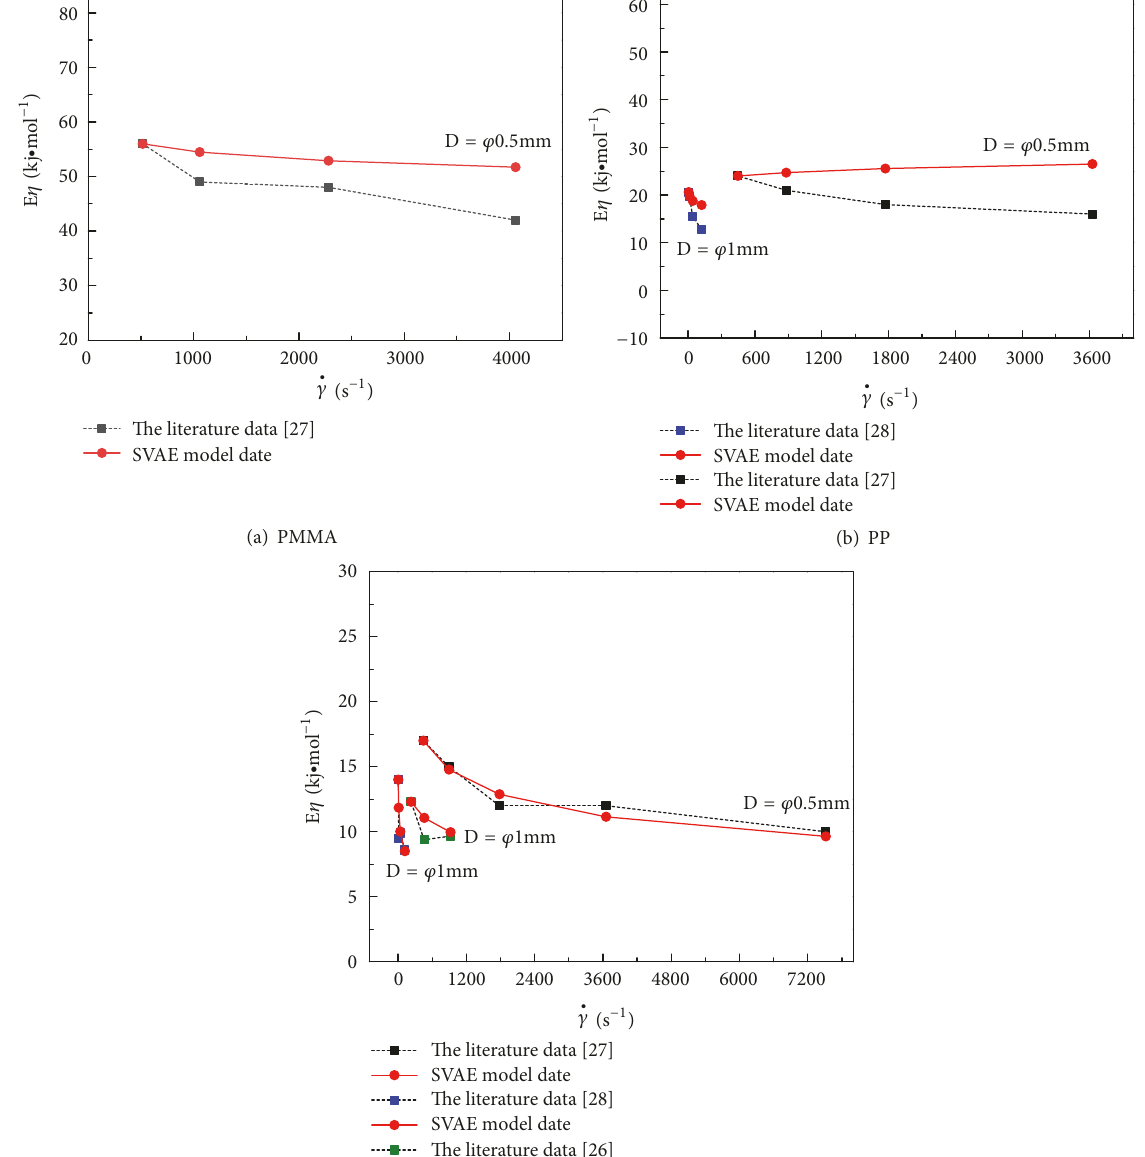
The traditional power law function model shown in (2) and the size-based non-Newtonian index model (SNNE) were used to calculate the non-Newtonian index values of PMMA, PP, and HDPE, respectively. The non-Newtonian index values are shown in Figure 6. The average errors of the SNNE models for the three materials were 2%, 1.7%, and 0.6%, respectively. Therefore, the established SNNE model has high precision and reliability for the prediction of non- Newtonian index values of polymer melts.